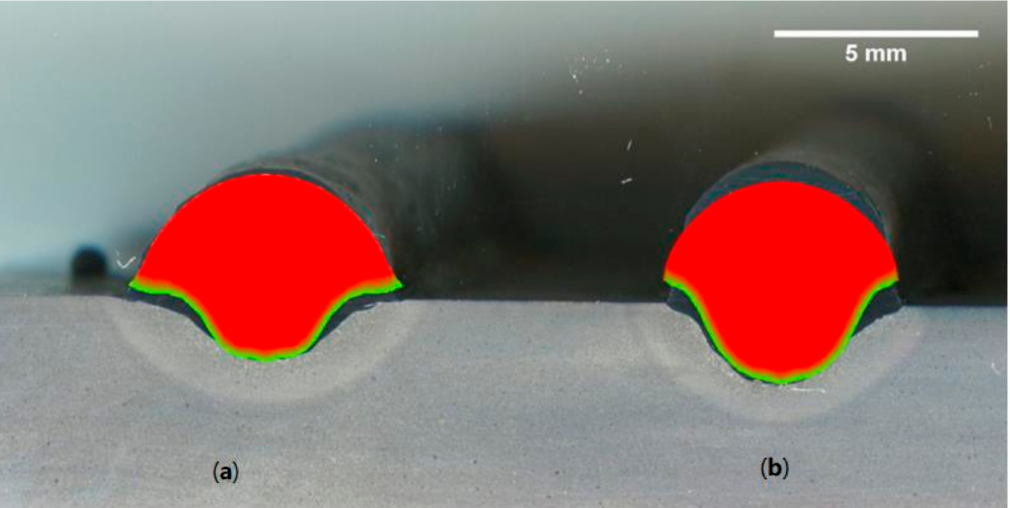
Figure 17. Melt region comparison for ( a ) a 500 ppm oxygen concentration with low heat flux, representing the binary blend, ( b ) 420 ppm oxygen concentration with high heat flux, representing the ternary